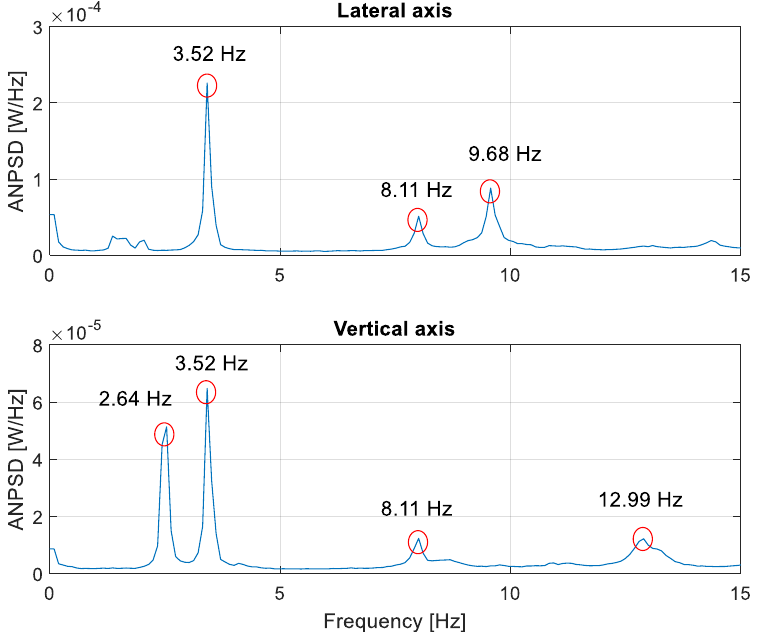
Figure 11. Averaged normalized power spectral densities for the lateral axis ( top ) and vertical axis ( bottom ) computed from acceleration time histories acquired by wireless sensors. Red circle represents natural frequencies identified through the peak-picking technique.